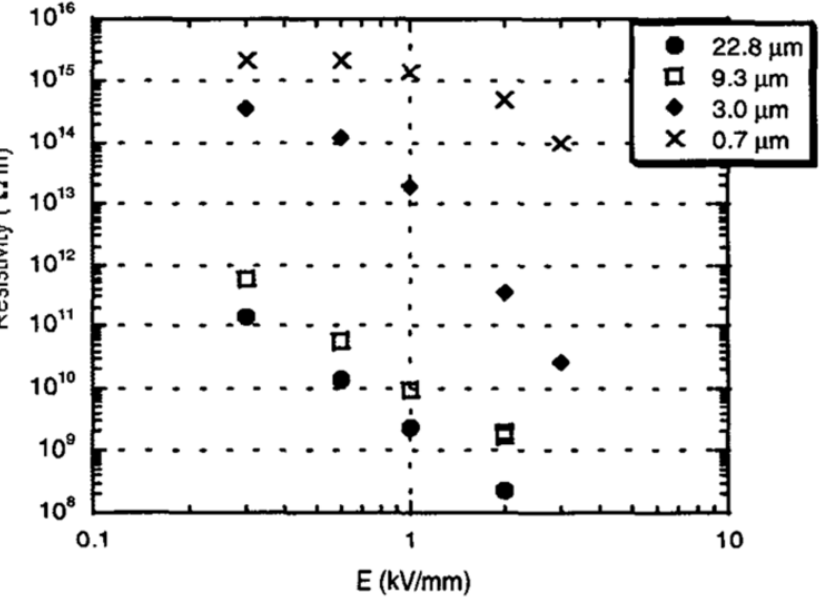
Figure 19. Resistivity as a function of electric field for composites involving SiC particles of various sizes. © 2021 IEEE. Reprinted, with permission, from [62].